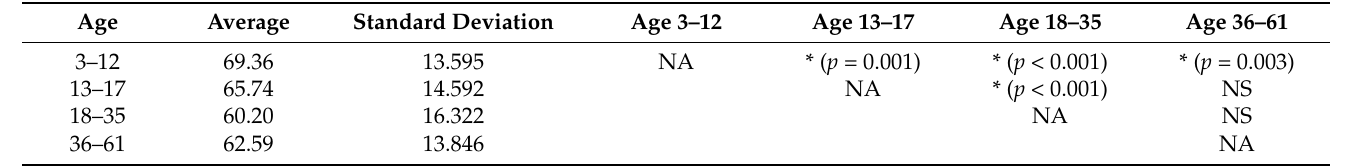
Table 3. Bonferroni multiple comparison test performed on the four age categories in relation to the feeling of well-being ( n = 1306).